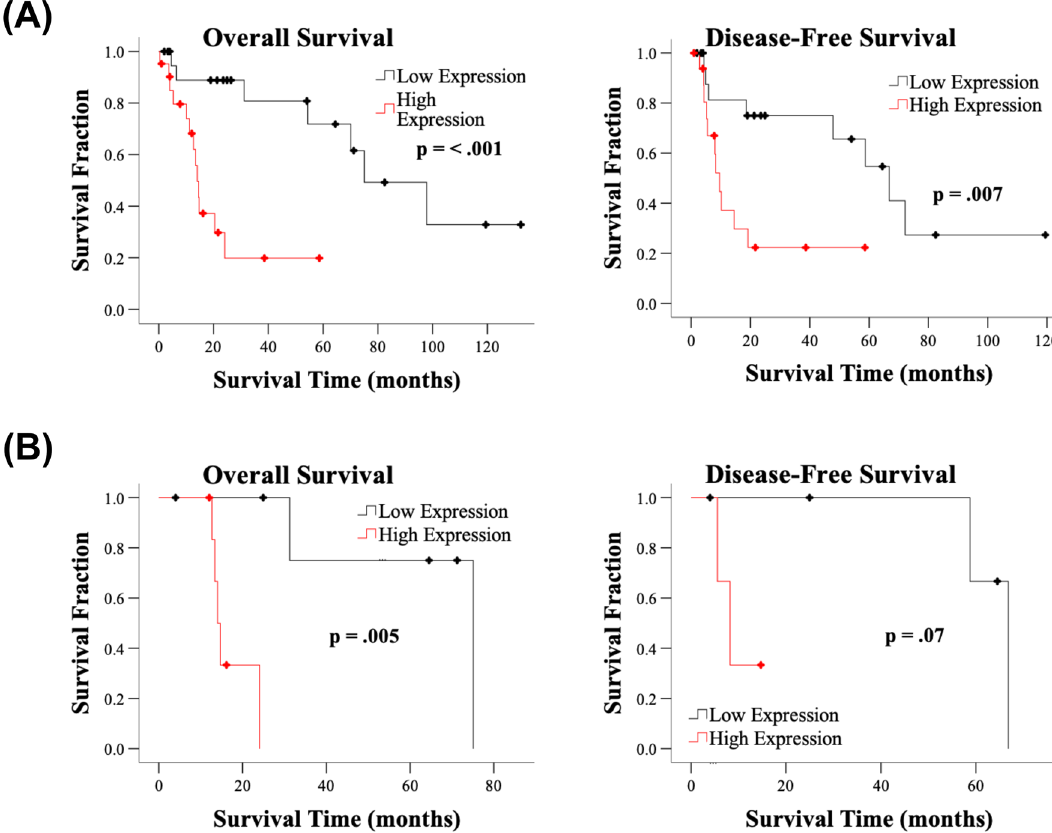
Figure 5. Smurf2 gene expression predicts tumor progression and mortality in patients with stage III squamous NSCLC. Overall survival and disease-free survival were significantly reduced in the high-Smurf2 expression groups of patients with stage III disease treated with chemotherapy (n = 85) ( A ) or treated with combined radiotherapy and chemotherapy (n = 25) ( B ). The black and red lines indicate the 1st and 4th quartiles of expression, respectively. See Table 1 for the associated HRs and 95%